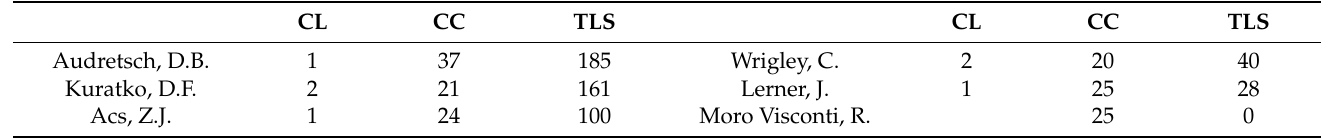
Table 11. Unicorns: Co-citation and total link strength of the top 10 most cited authors. CL CC TLS